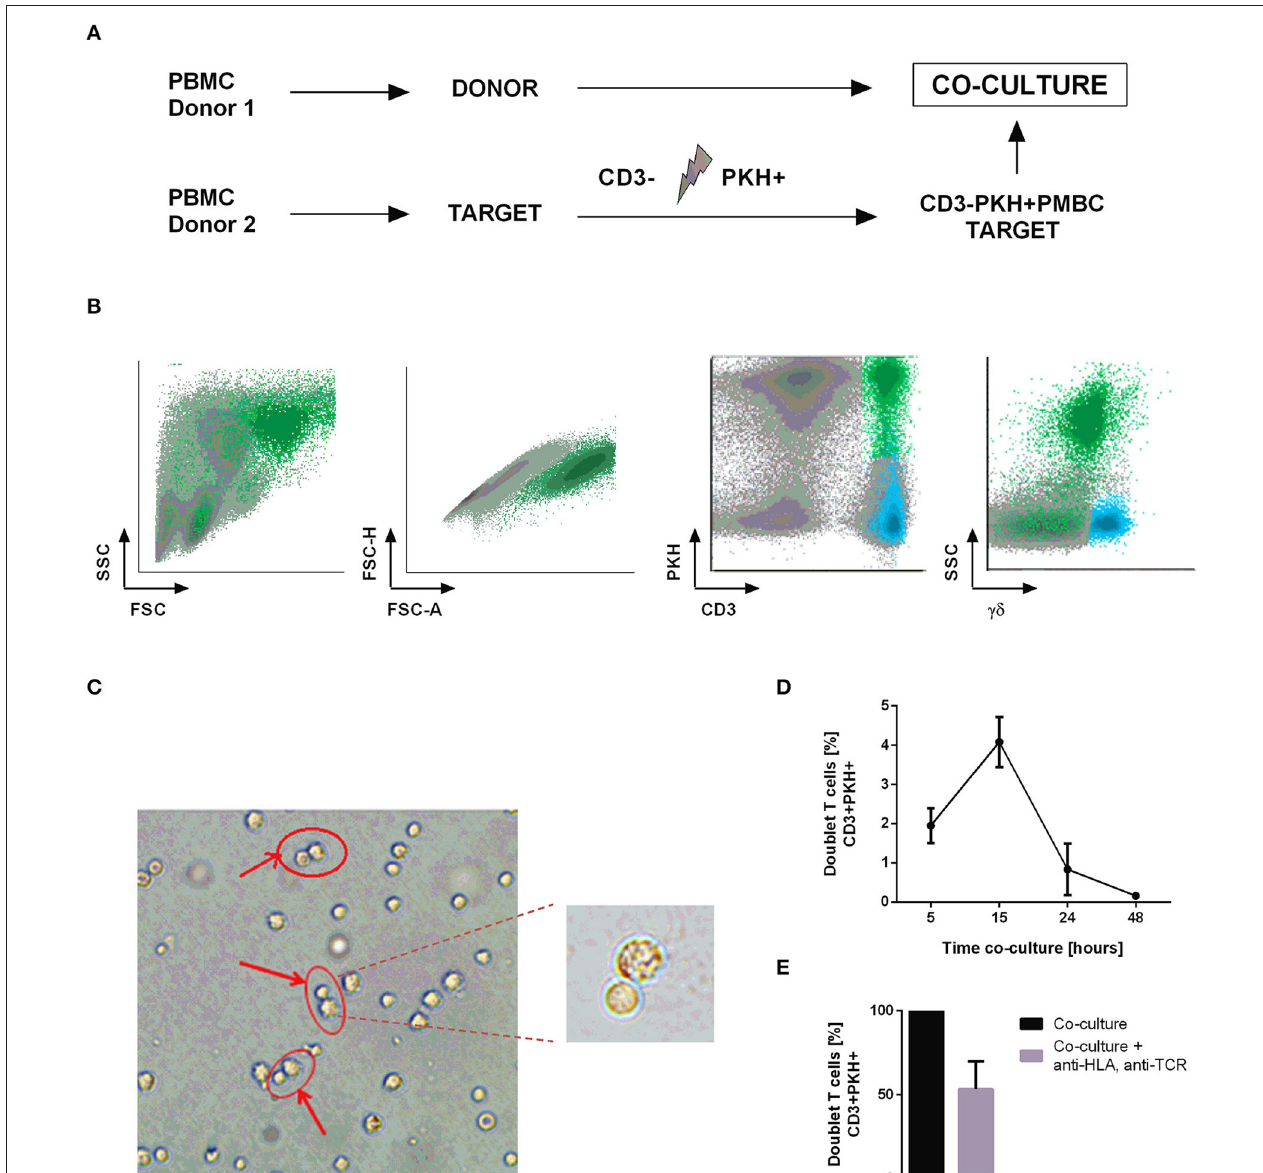
FIGURE 1 | Identification and isolation of doublet-forming T cells. (A) Schedule of the procedure: PBMC from two healthy donors were obtained by density gradient centrifugation. Target PBMC were depleted of CD3 cells, irradiated and stained with PKH-67 (CD3–PKH + PBMC). Co-cultures of donor’s PBMC and target CD3–PKH + PBMC were performed. (B) Doublet-forming T cells were identified by flow cytometry as a population with higher FSC/SSC, doublet zone FSC-H/FSC-A and expression of both CD3 and PKH (CD3 + PKH + ). (C) Doublet-forming T cells were also identified under confocal microscope. (D) Representation of the percentage of doublet T cells vs. co-culture time (hours) is shown. Depicted are the mean ± SD of three independent experiments. (E) The bar diagram shows the percentage of doublet-forming T cells (CD3 + PKH + ) in presence or absence of HLA-A,B,C, and αβ TCR antibodies. Depicted are the mean ± SD of three independent experiments (performed in duplicates).